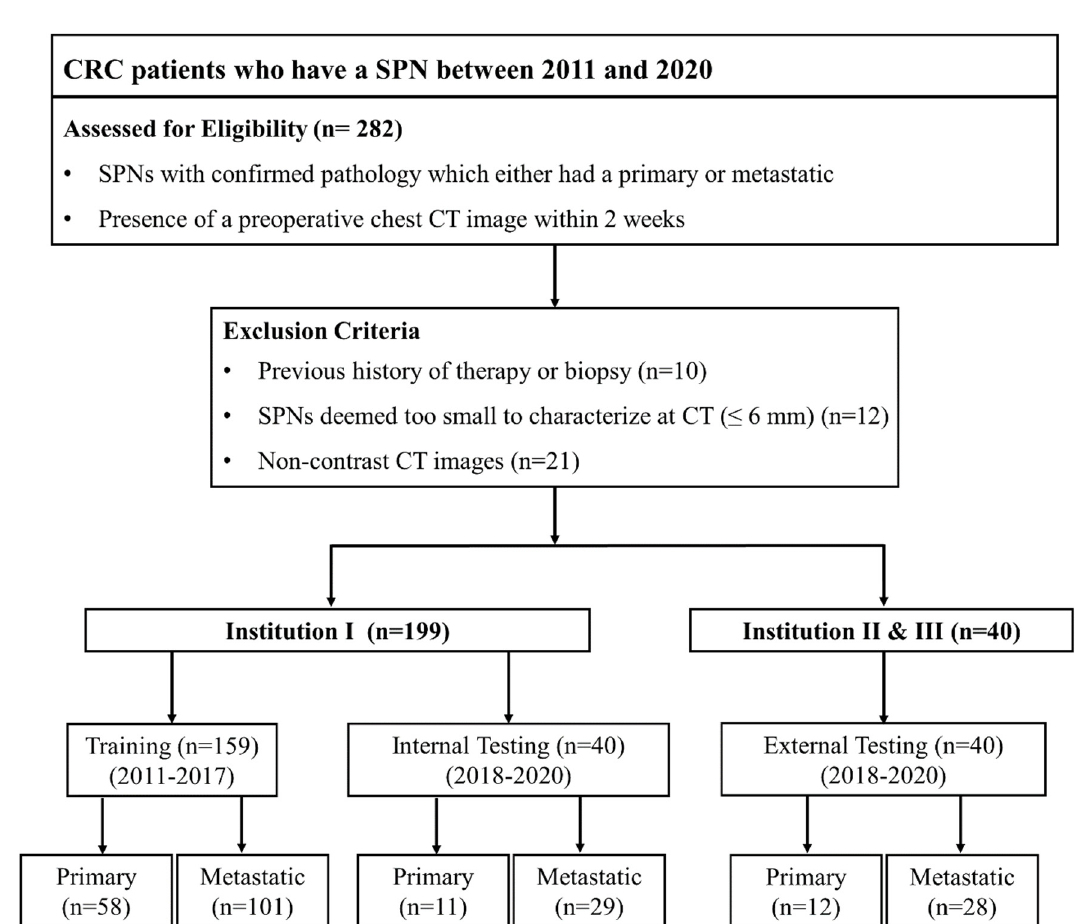
Figure 1. Flow diagram of the study.